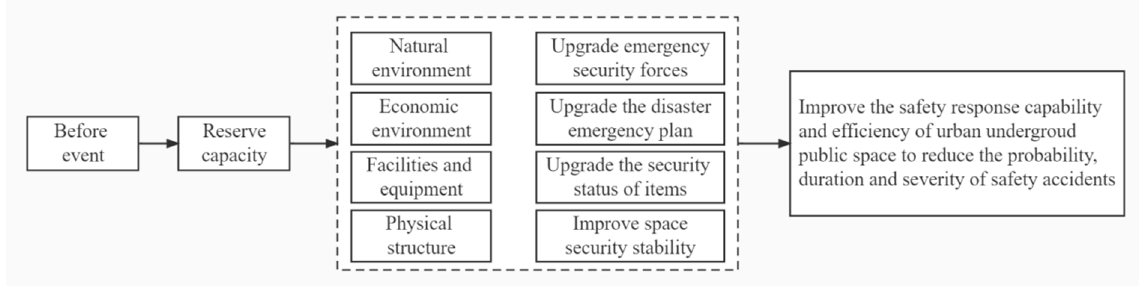
Figure 6. The proposed actions to improve the ex-ante resilience strategy for the underground public space (UPS) system.